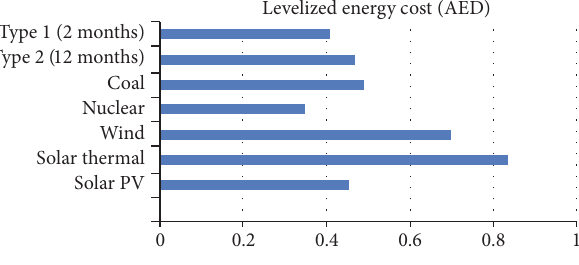
Figure 6: Levelized Energy Cost